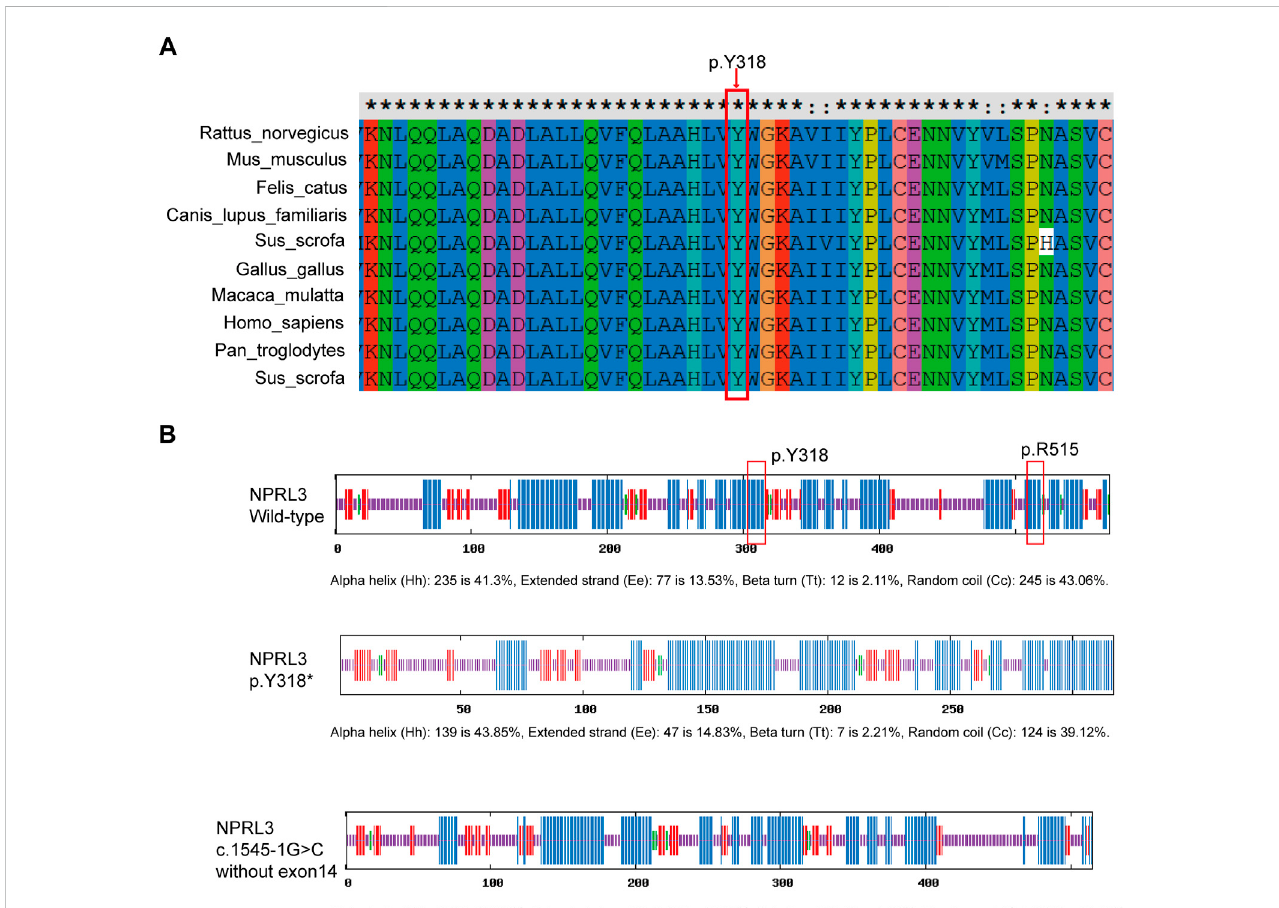
FIGURE 3 Conservation of p.Y318 in NPRL3. (A) Conservation of p.Y318 in NPRL3 across several species: Homo sapiens (human), Rattus_norvegicus (Rat), Mus musculus (Mouse), Canis lupus familiaris (Dog), Macaca mulatta (Rhesus macaque), and other different species. The p.Y318 is highly conserved among differentspecies. The red box indicates the location of the mutationchange. (B) Effects of thep.Y318* and (C) 1545-1G > C variants on the secondary structure of the NPRL3 protein predicted by SOPMA (https://npsa-prabi.ibcp.fr/cgi-bin/npsa_automat.pl?page=/NPSA/npsa_sopma.html). The blue bar indicates the α -helix, the red bar indicates the extended strand, the green bar indicates the ß -turn, the yellow bar indicates the random coil. The red box indicates the location of the mutation